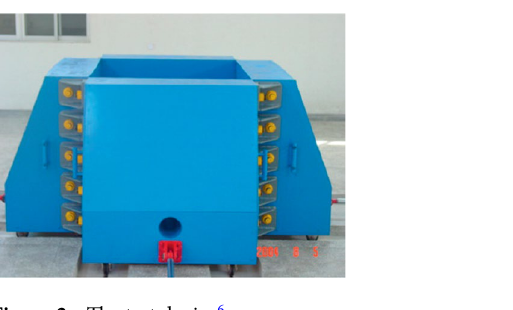
Figure 2. The test device 6